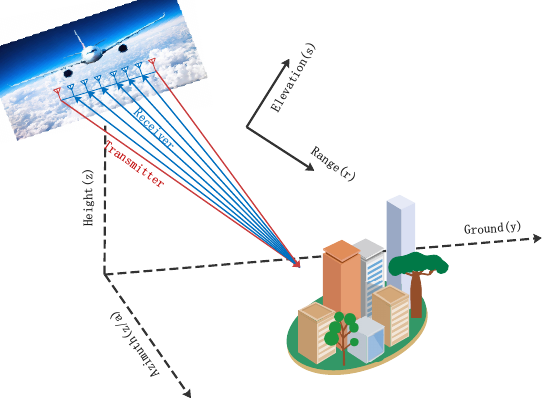
Figure 1. Geometric model of airborne array TomoSAR imaging under ideal